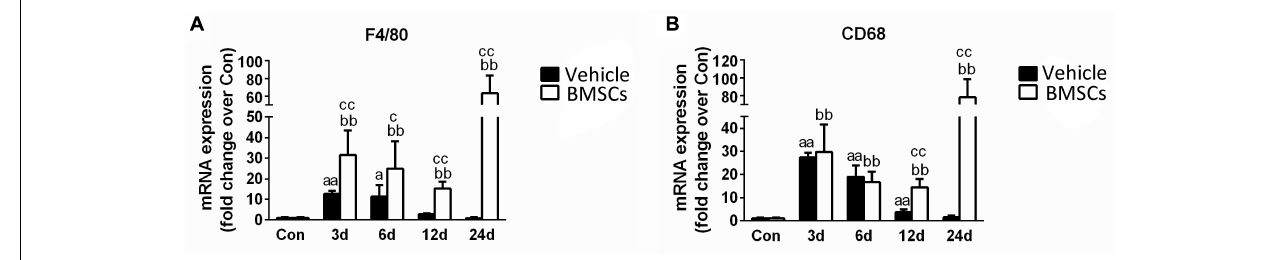
FIGURE 6 | The effects of BMSCs treatment on the expression of macrophages. Vehicle, muscle contusion and vehicle treated group; BMSCs, muscle contusion and BMSCs treated group. (A) The expression of F4/80 mRNA after skeletal muscle injury. (B) The expression of CD68 mRNA after skeletal muscle injury. Data are means ± S.D., n = 8; a Significant difference from control, P < 0.05; aa P < 0.01. b Significant difference from control, P < 0.05; bb P < 0.01. c Significant difference from the same time points of group vehicle, c P < 0.05; cc P < 0.01. F4/80, the specific marker of macrophage membrane; CD68, the specific marker of